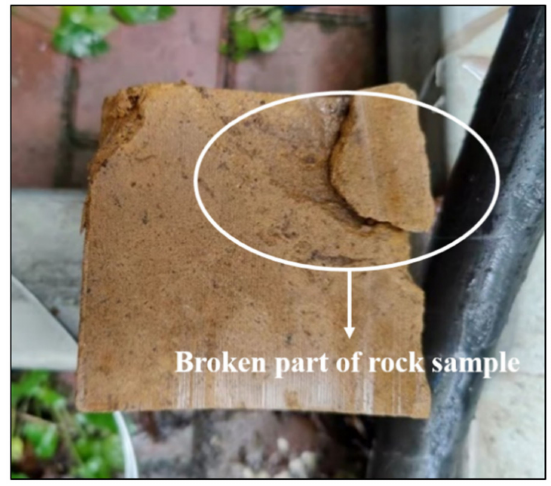
Figure 8. Post-experimental yellow sandstone rock sample.